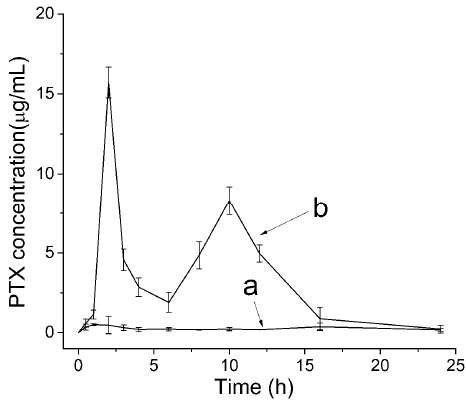
Figure 13. Mean ( ± SD) plasma concentration-time curves after oral administration of raw PTX ( a ) and PTX crystal powders suspension ( b ) at a dose of 10 mg / kg for PTX ( n =